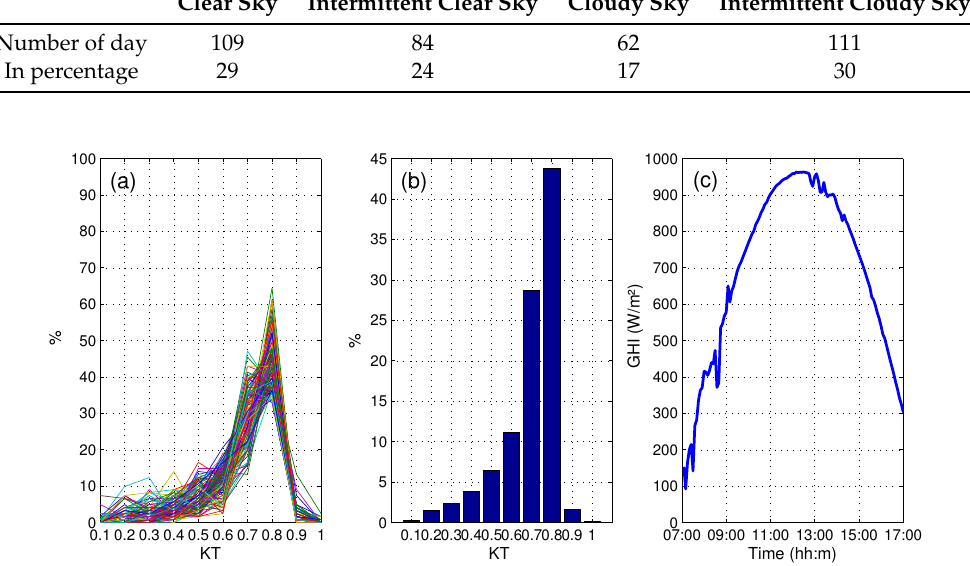
Figure 10. Class representing clear sky day event: ( a ) clearness index of 109 clear sky days; ( b ) average K t histogram of the 109 clear sky days; and ( c ) a clear sky day GHI